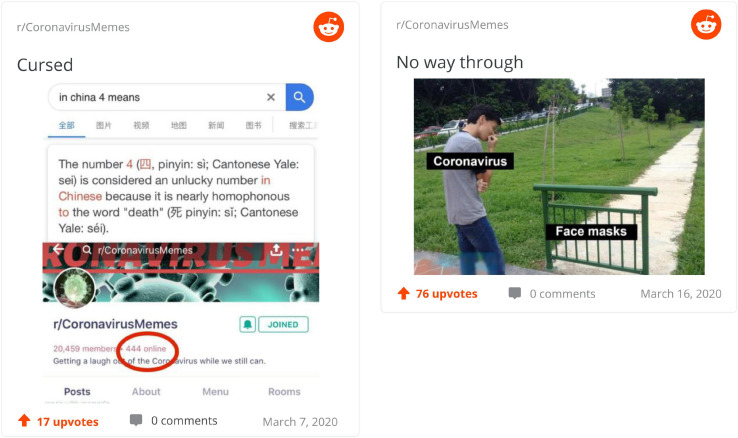
Top creative memes.